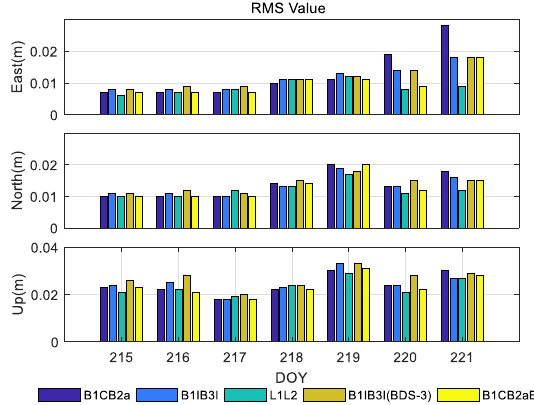
Figure 6. TGCU – TGBU (30 km) medium baseline RTK positioning accuracy. Table 6. TGCU – TGBU (30 km) average of medium baseline RTK RMS and ambiguity fixing rate.